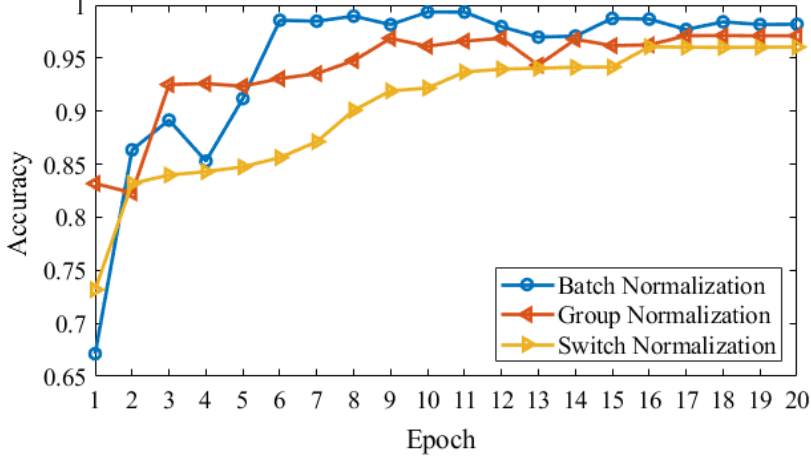
Figure 6. Validation accuracy with three normalization techniques applied to the AD dataset.